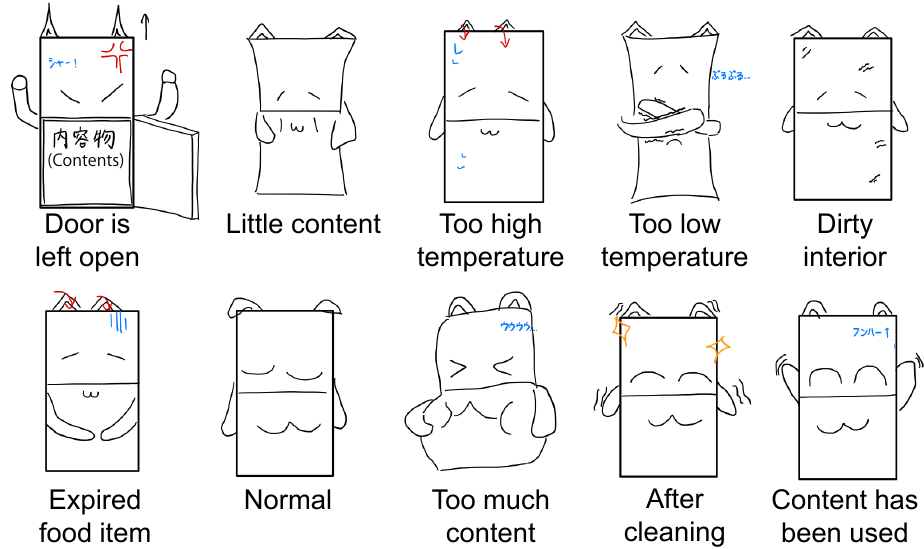
Figure 2. The design of the refrigerator agent discussed in the final group